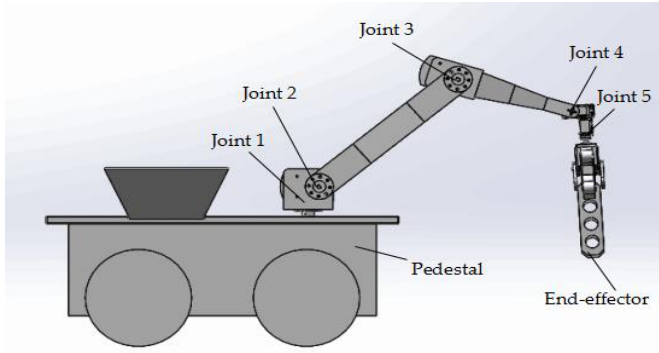
Figure 2. A five-Degree-of-Freedom articulated pickup manipulator.